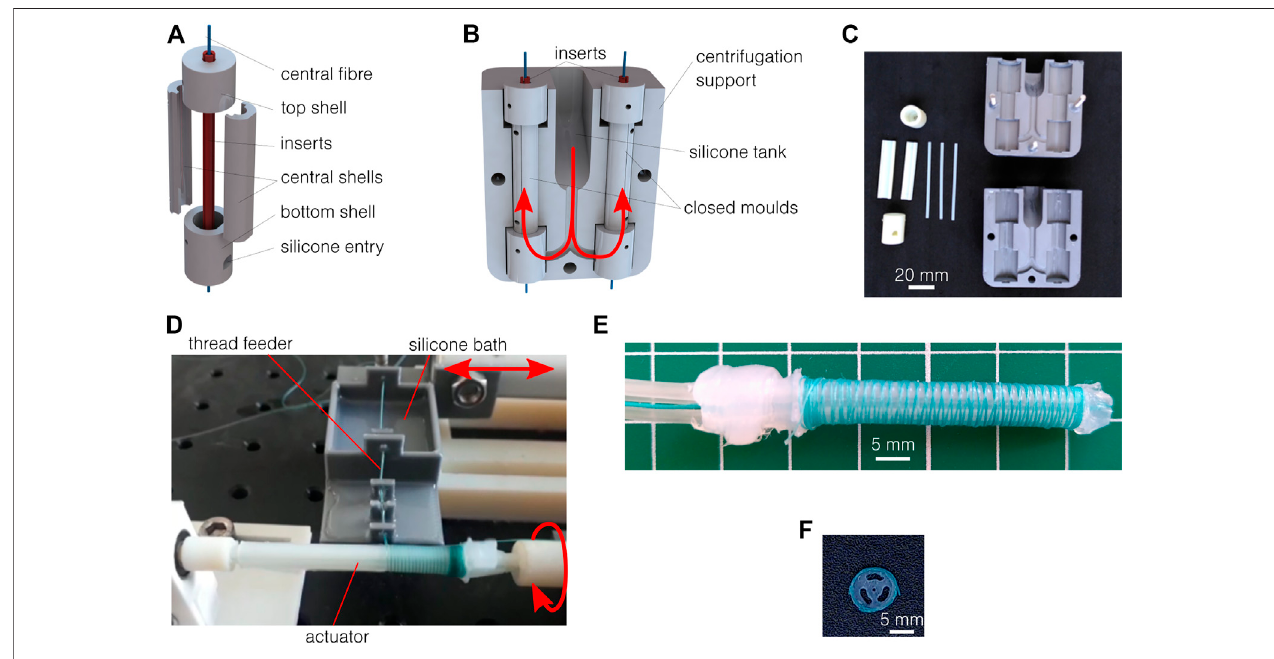
FIGURE2| Vacuumcentrifugalovermoldingprocess. (A) Themoldismadeofsevenpartsplusthecentral fi bertobeovermolded. (B) Theclosedmoldisplacedin a two-part support, which includes a tank for the uncured silicone. When centrifuged, the silicone fl ows along the red arrows. (C) 3D printed molds and supports. (D) Setup for fi ber reinforcement. (E) Results of the fabrication process after reinforcement, sealing, and assembly. (F) The cross-section respects the designed